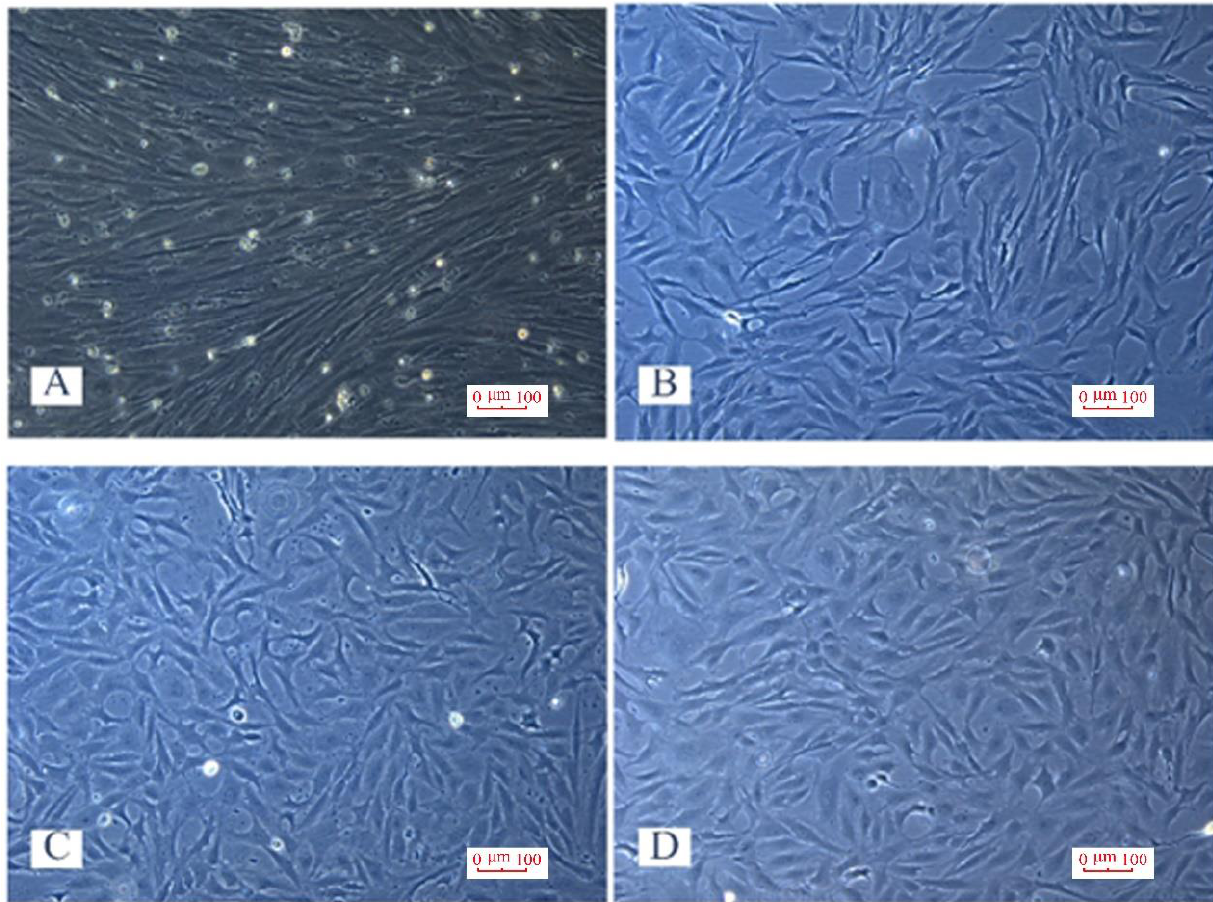
Figure 1. Morphology of TAH-11 cell monolayers: ( A ) Passage 5; ( B ) Passage 20; ( C ) Passage 50; ( D ) Passage 70. Scale bar = 100 μm.